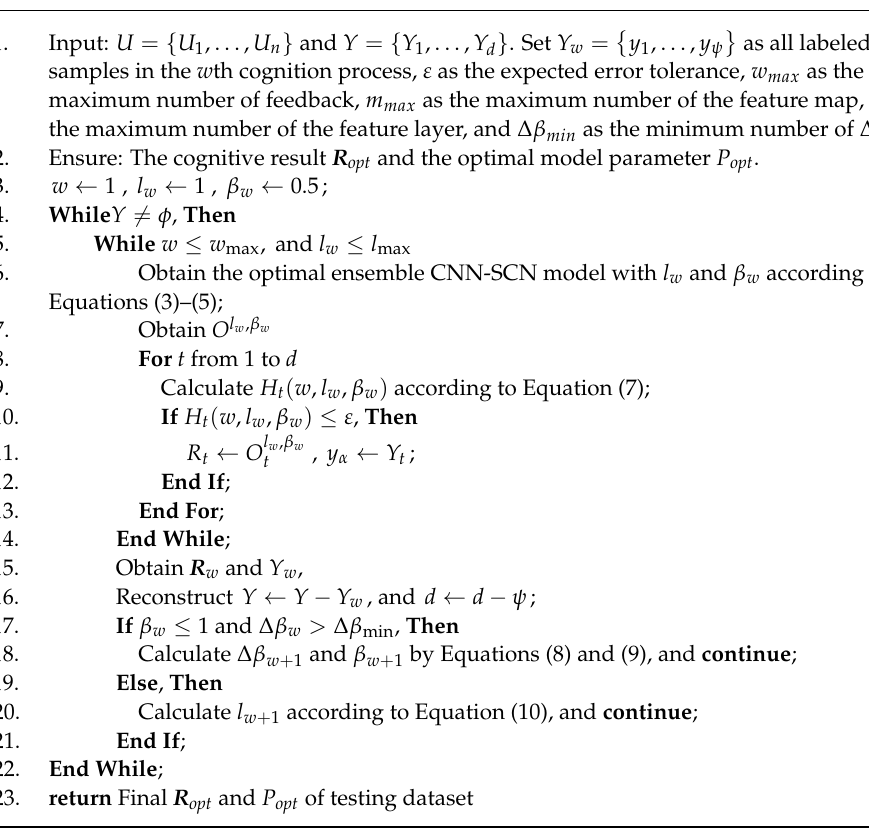
Algorithm 1: The feedback cognitive algorithm for greengage grading based on dynamic feature and ensemble